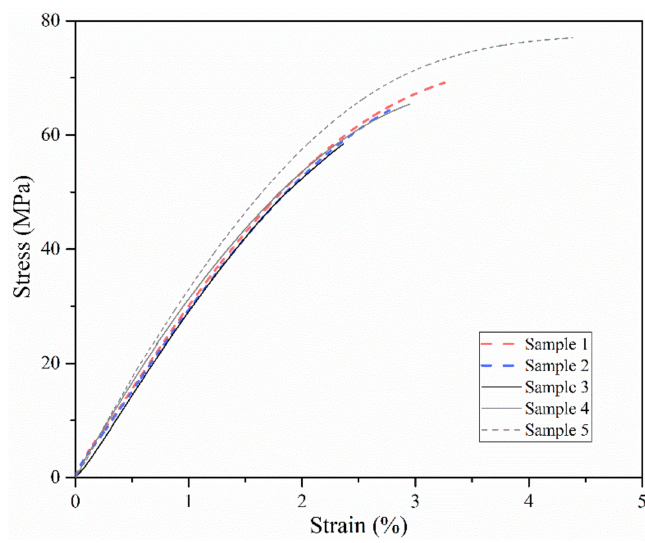
Figure 6. Tensile stress–strain curves of Experiment No. 25.